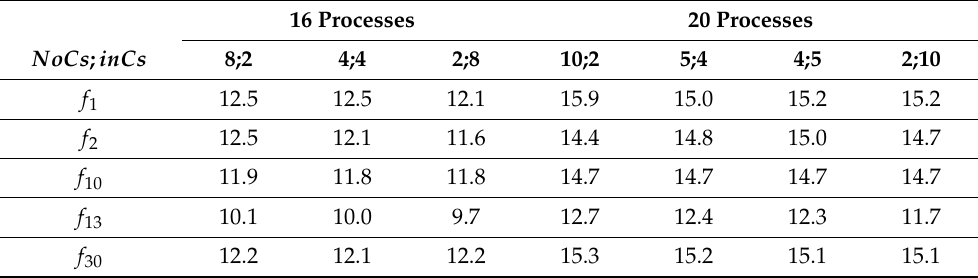
Table 7. Parallel speed-up for the two-level parallel algorithm using groups of processes. Population size = 240.